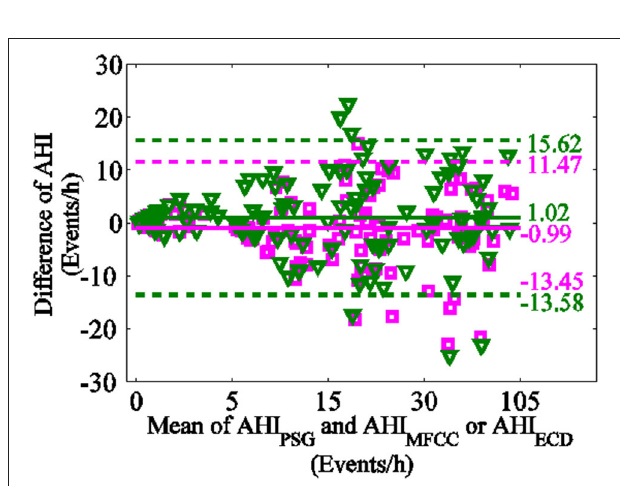
FIGURE 8 | Bland-Altman-plot (the difference of AHI PSG and AHI ECD with pinkish, the difference of AHI PSG and AHI MFCC with green).